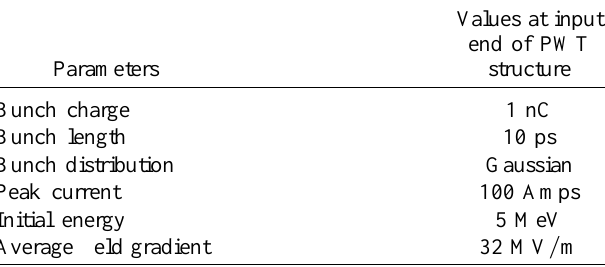
TABLE III. Input beam parameters for PARMELA simulations. Parameters structure